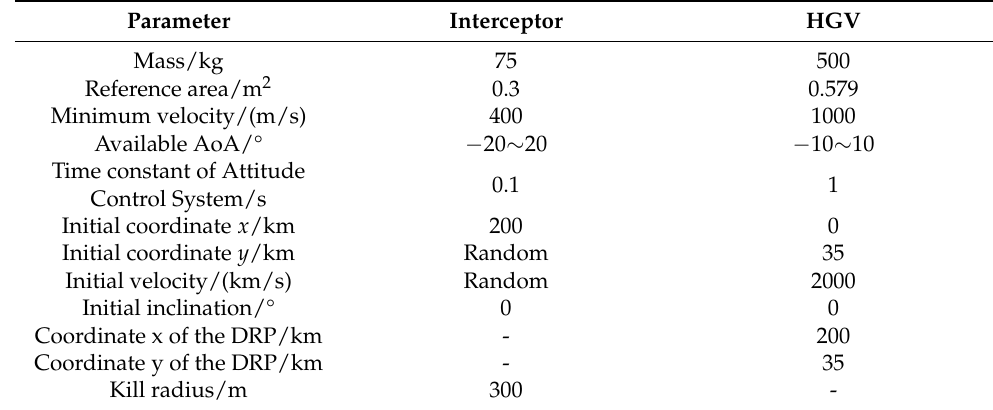
Table 1. Parameters of theHGV and interceptor in the virtual scenario.